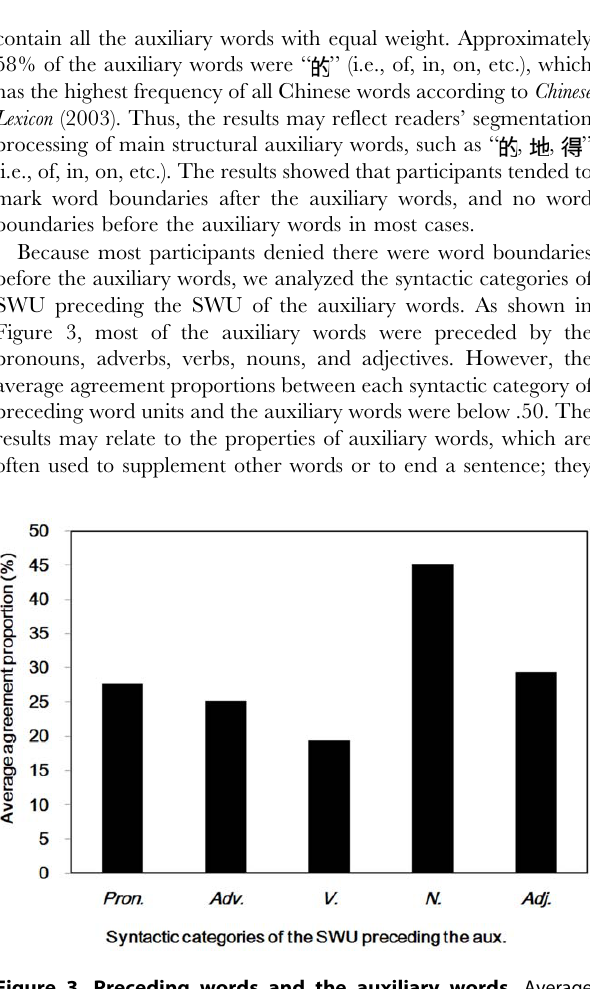
Figure 2. Auxiliary words. Frequency distribution of agreement proportions for word boundaries before (open squares) and after (filled circles) the SWU of total auxiliary words. The x-axis represents the average proportions of all of the participants who indicated that there were word boundaries before or after the SWU. The y-axis represents the proportion of SWU in the classes. The number of SWU is also represented in the figure.